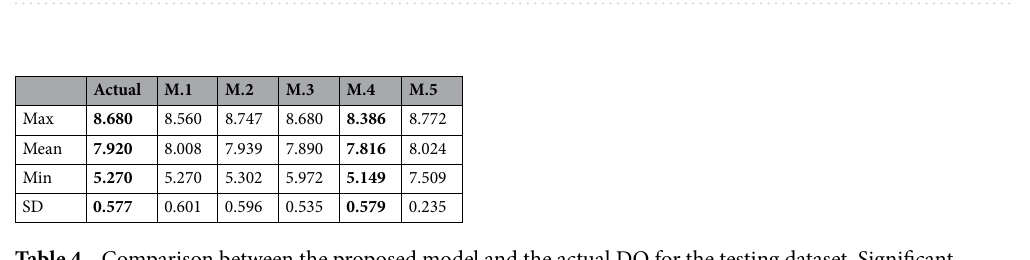
Table 4. Comparison between the proposed model and the actual DO for the testing dataset. Significant values are in bold.